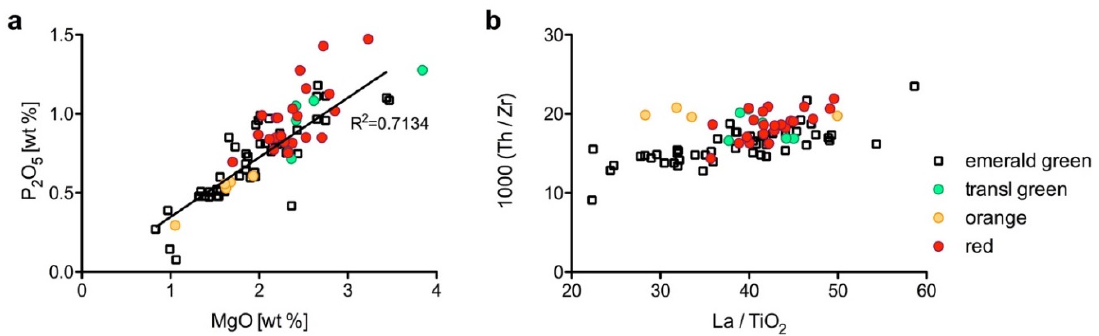
Figure 8. Red, green, and orange plant ash glasses in comparison with first century emerald green vessel glass. ( a ) The tesserae have high phosphorus oxide levels that are positively correlated with magnesia, similar to the emerald green vessel glass; ( b ) the tesserae from Noheda and the emerald green vessels share the same Th/Zr versus La/TiO 2 ratios that suggest a common, most likely Egyptian origin. Distinct glass-coloring recipes also underlay the red and orange tesserae. Metallic copper